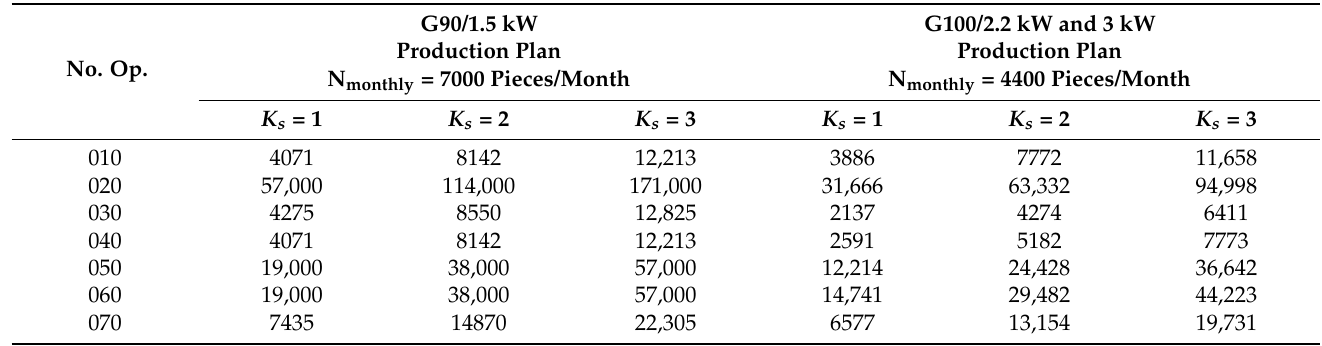
Table 3. The production capacity for each assembly-mounting